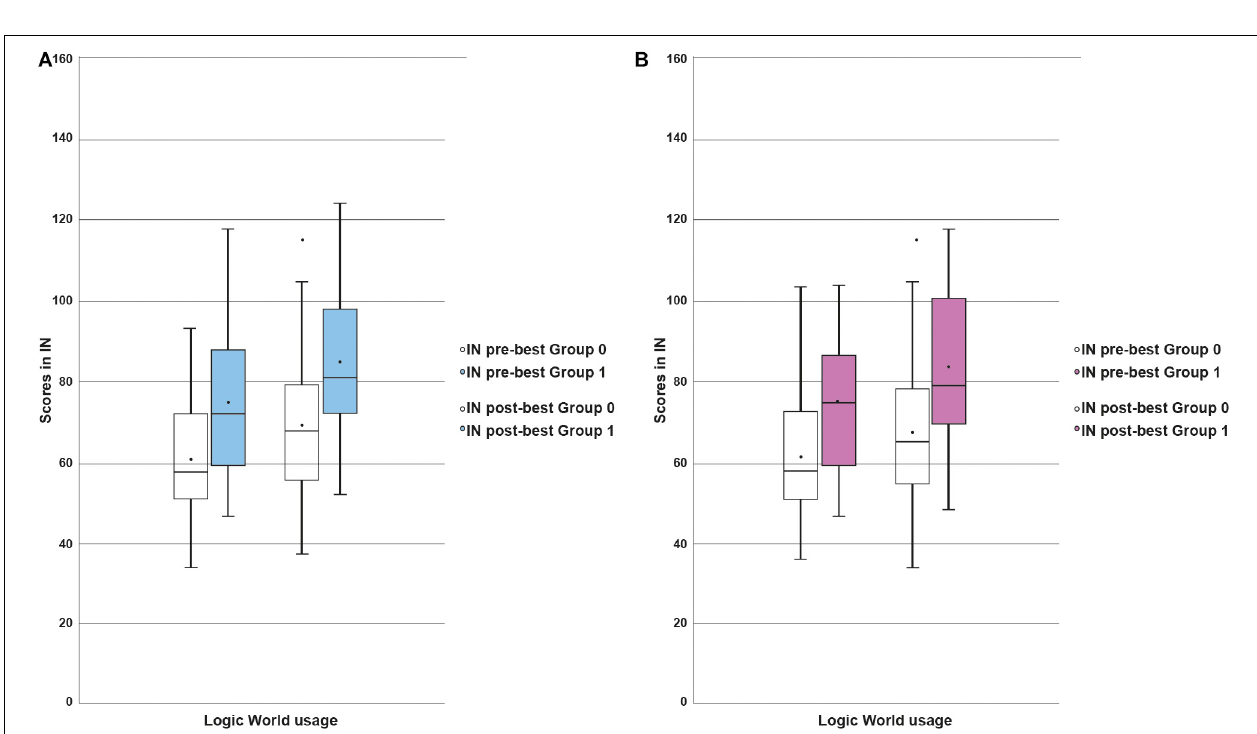
FIGURE 7 | Graphics of the differences between group 0 (less use) and group 1 (more use) to scores taken at IN (A) with the use of Logic activities (B) with the use of Spatial activities.